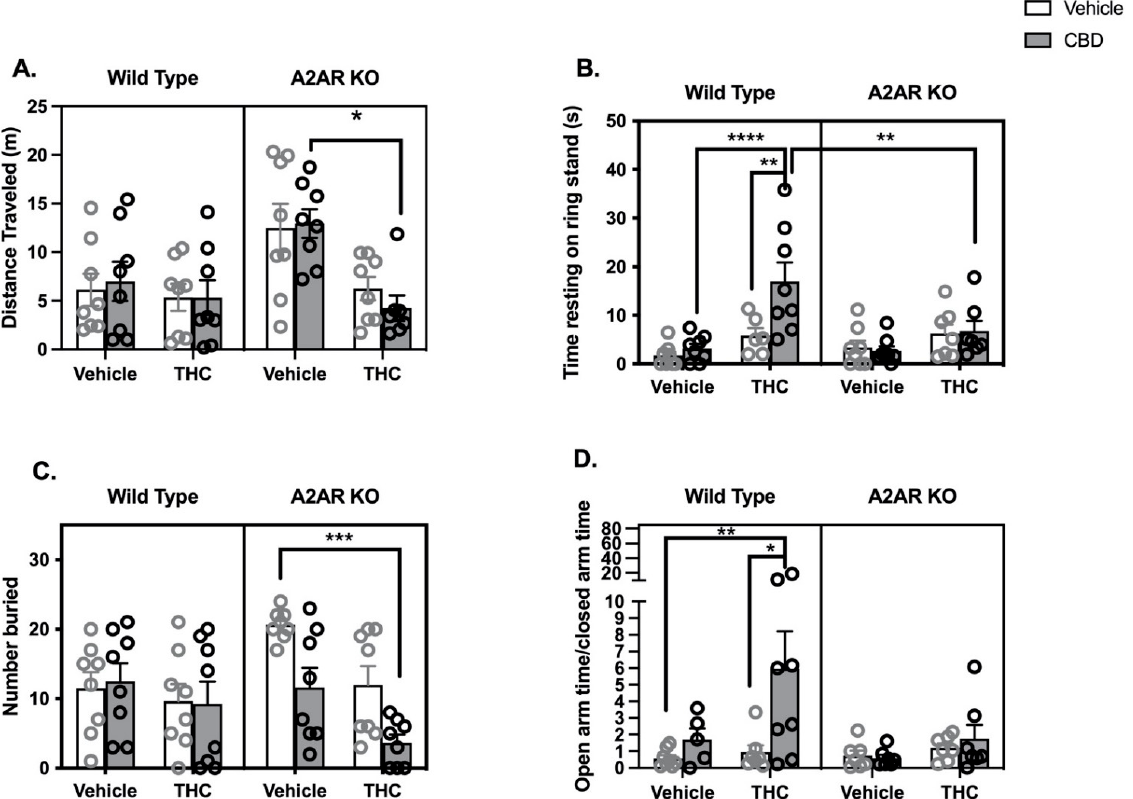
Figure 2. Behavioral effects of THC (5 mg/kg), CBD (5 mg/kg) and their combination in wild type (WT, open bars and gray symbols) and A2AR null (A2AR-KO, closed bars and black symbols) mice. ( A ) Drug effects on distance moved in 15 min while in a cylindrical open field arena. One outlier was identified in the CBD/THC/A2AR-KO group. ( B ) Drug effects on cataleptic behavior in the ring stand assay. Outlier analysis indicated 4 outliers in this data set (2 in the WT/VEH/THC group, 1 in the KO/VEH/THC group and 1 in the KO/THC/CBD group). ( C ) Drug effects on the number of marbles buried. ( D ) Drug effects on the ratio of time spent in the open and closed arms of the EPM. A total of 8 mice were removed from the analysis; 3 mice became immobile on the open arm (2 in the WT/veh/CBD group and 1 in the KO/THC/CBD group); and 5 additional mice were identified as statistical outliers (1 each in the WT/veh/CBD, WT/veh/THC, KO/veh/veh, KO/veh/THC and KO/veh/CBD groups). Bars represent the mean, and vertical lines are the standard error of the mean. * p < 0.05, ** p < 0.01, *** p < 0.001, **** p < 0.0001.